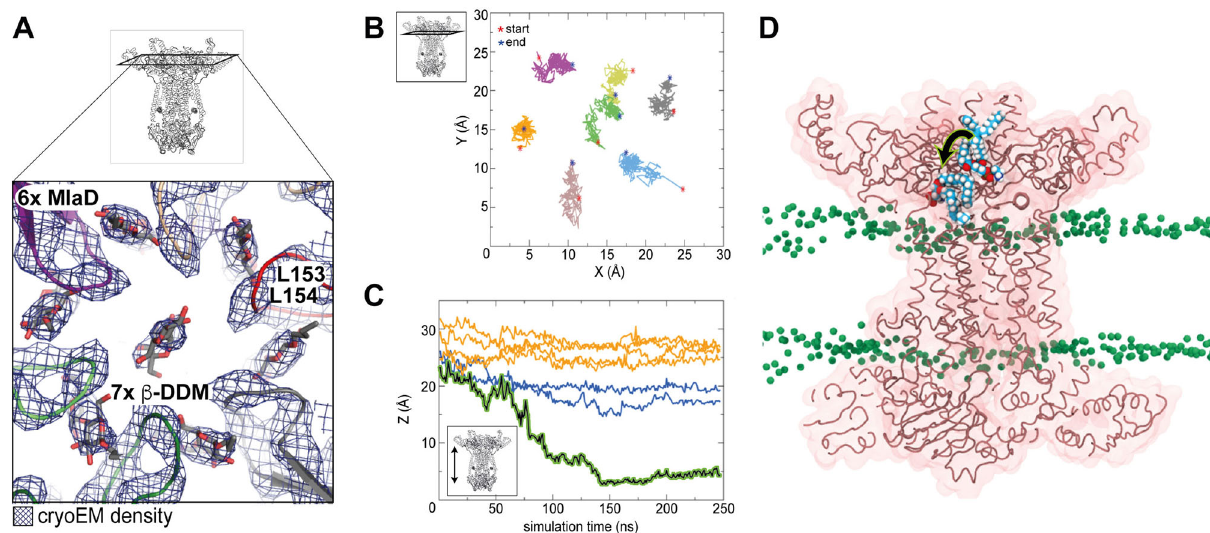
Fig. 3 Lipid position and dynamics in the MlaD basket. A Close-up of the periplasmic MlaD basket that houses six peripheral and one central detergent molecule. B – D Spontaneous fl ipping of the centrally bound lipid within the basket region of MlaBDEF ab during 250ns molecular dynamics simulations. Panel ( B ) shows the centre of mass motion of the seven lipids in the xy plane. They are con fi ned to an area of ~5 × 5 Å, indicating this is a high lipid af fi nity region. Panel ( C ) shows the centre of mass movement of the seven lipids in the z dimension as a function of time. The lipid shown in panel ( A ) corresponds to the black curve showing a clear movement towards the cytoplasmic end. Three other lipids (blue) move into this channel but to a lesser extent than the aforementioned lipid, whereas three others (orange) remain close to their starting positions. Simulations from a model at the reported resolution cannot clarify the directionality of the movement, but rather that these regions are conduits for lipids. Panel ( D ) shows a cutaway view of the protein with a POPE lipid at two time points during the simulation, time = 0 ns and 150 ns. The simulation was initiated with seven POPE lipids placed at the periplasmic end of the protein corresponding to the density for detergents in the cryo-EM data (Supplementary Table 2). The lipid which is displaced more towards the cytoplasmic end is from the frame at t = 150 ns. The central hydrophobic ‘ channel ’ of the protein is a clear conduit for lipids given the spontaneous movement of POPE into this region in just 150